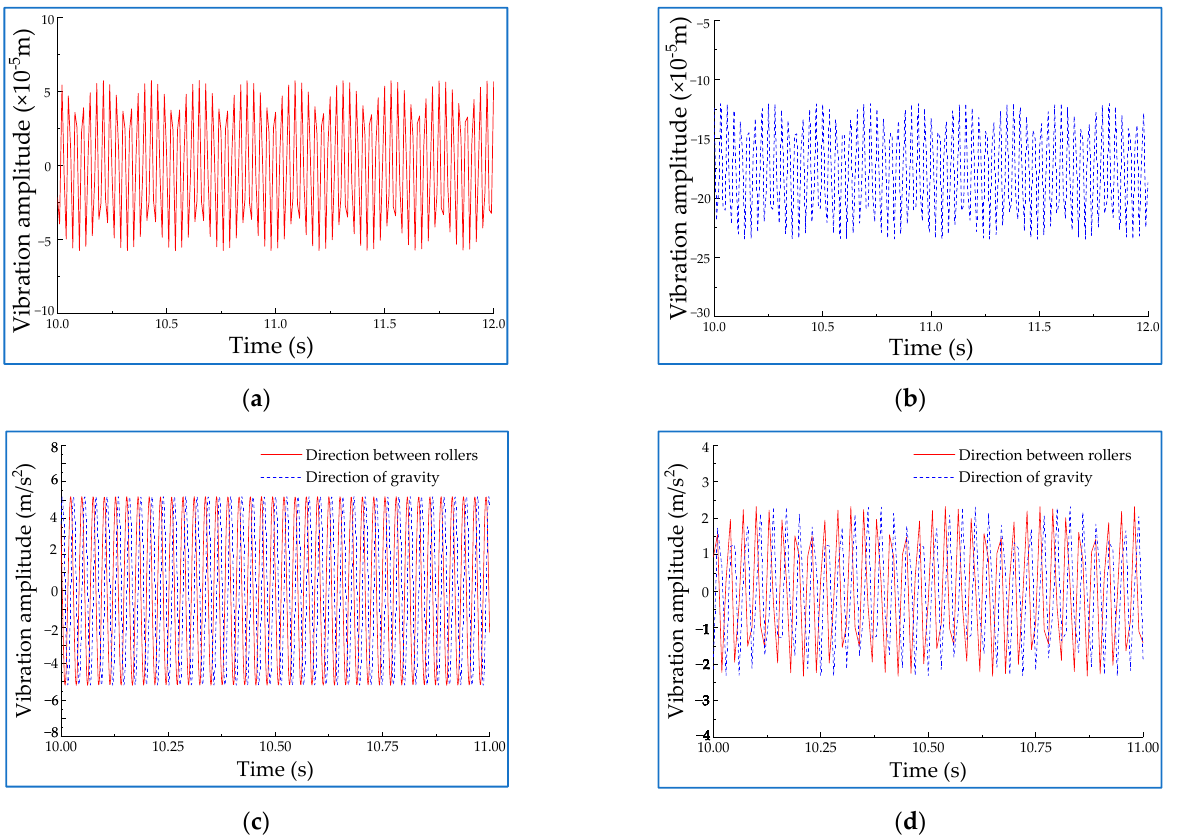
Figure 3. The vibration amplitude and the acceleration of the roller at 1000 rpm. ( a ) Vibration amplitude diagram of rollers direction; ( b ) Vibration amplitude diagram of gravity direction; ( c ) The calculated critical vibration acceleration before the unstable operation of the equipment occurring; and ( d ) Vibration acceleration diagram of rollers’ direction and gravity.